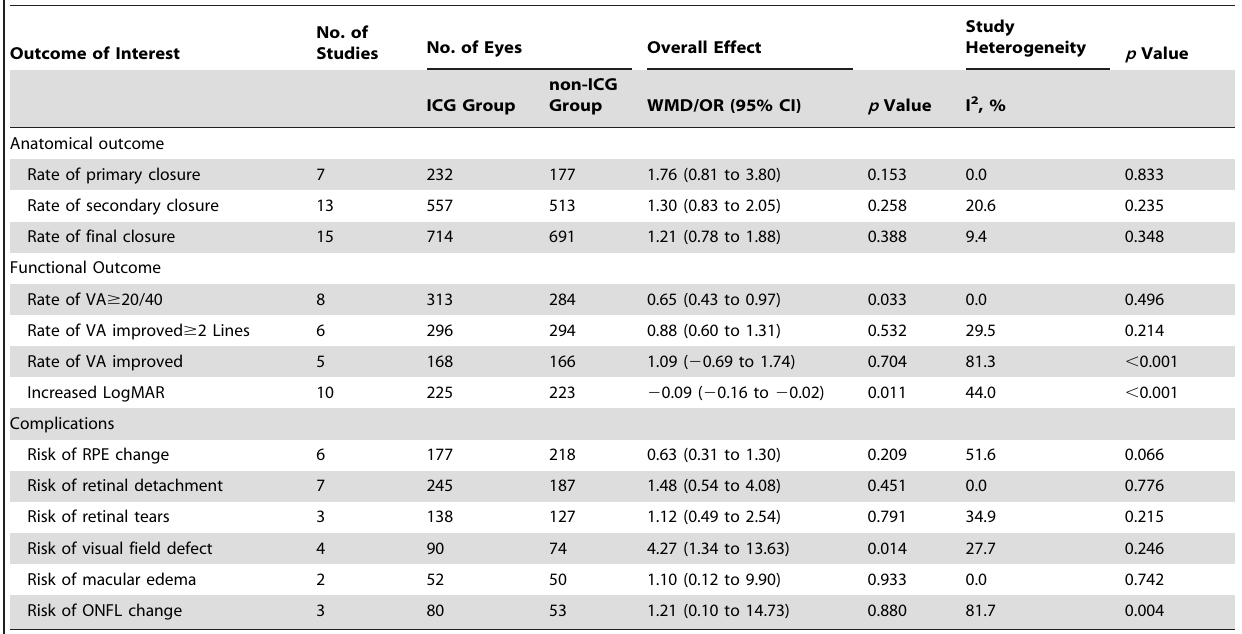
Table 4. Description of the main results of meta-analysis.